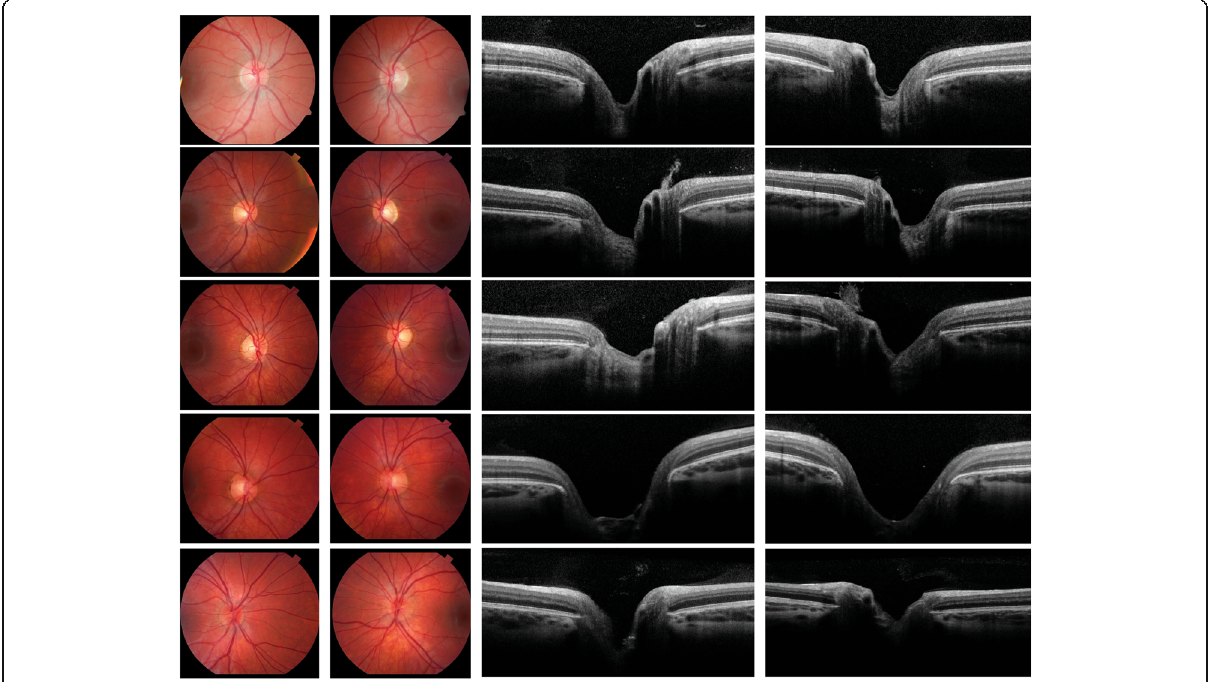
Fig. 4 Optic nerve photographs and horizontal optical coherence tomography of the optic nerve. The first and third columns depict the right eye and second and fourth columns depicts the left eye of individuals in the sixth generation of the cavitary optic disc anomaly pedigree. Top row, individual VI.1. Second row, individual VI.2. Third row, individual VI.3. Fourth row, individual VI.4. Fifth row, individual